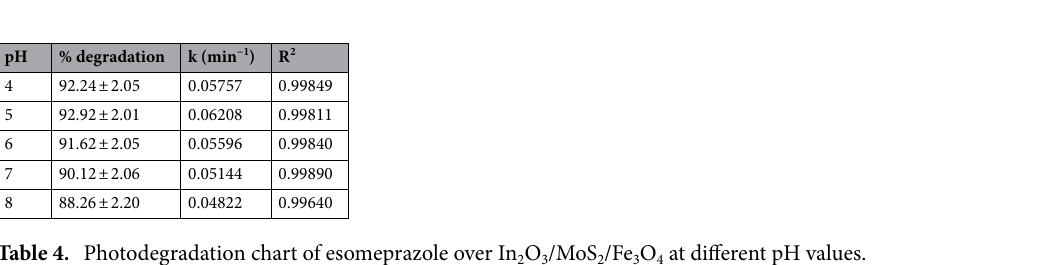
Table 3. Photodegradation chart of esomeprazole over In 2 O 3 /MoS 2 /Fe 3 O 4 at different concentrations of esomeprazole.